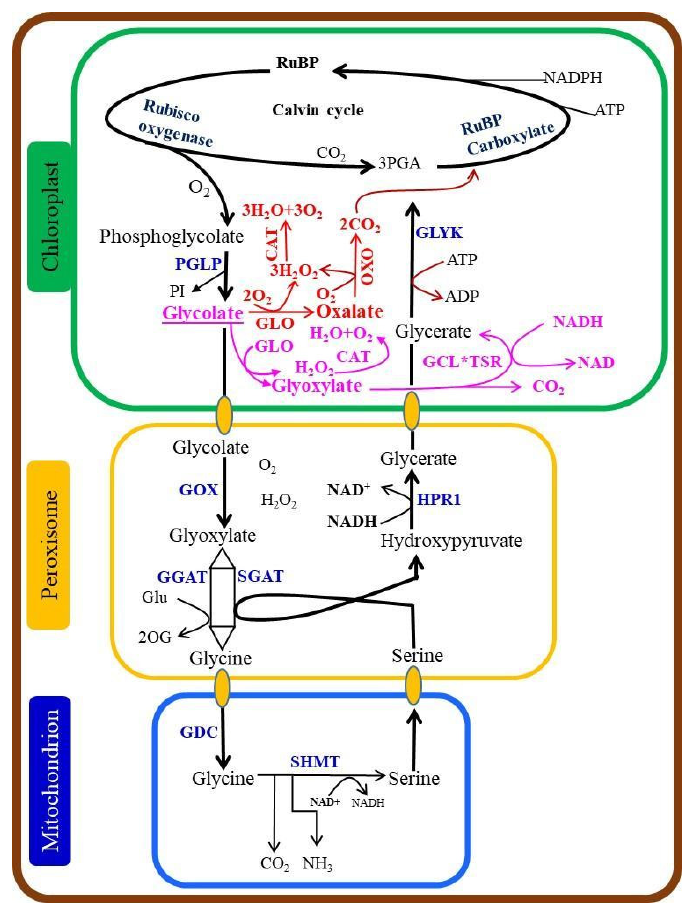
Figure 1. Photorespiratory pathway involving three organelles, i.e., chloroplast, peroxisome, and mitochondrion, for refixation of CO 2 . Enzymes involved in the pathway are provided in blue color. The photorespiratory bypasses are provided in red/pink. NAD: Nicotinamide adenine dinucleotide; NADPH: Nicotinamide adenine dinucleotide phosphate; PGLP: 2-phosphoglycolate phosphatase; GLYK: Glycerate-3-kinase; GOX: Glucose oxidase; HPR1: Hydroxypyruvate reductase 1; GGAT: Gamma-glutamyltransferase; GDC: Glycine decarboxylase complex; SHMT: Serine hydroxymethyl- transferase. GCL: Glyoxylate carboligase; TSR: Tartronic semialdehyde reductase.